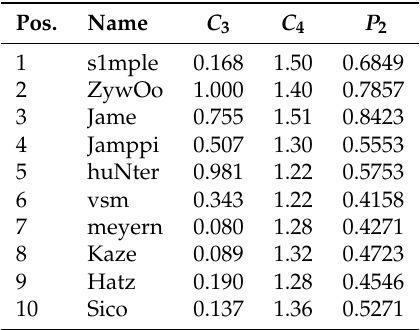
Table 6. The performance table of the selected criteria C 3 , C 4 and assessment model P 2 .